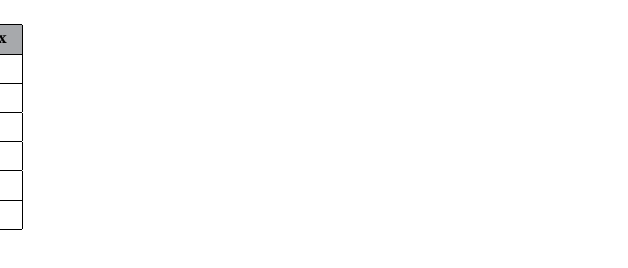
Table 1. Typical properties of